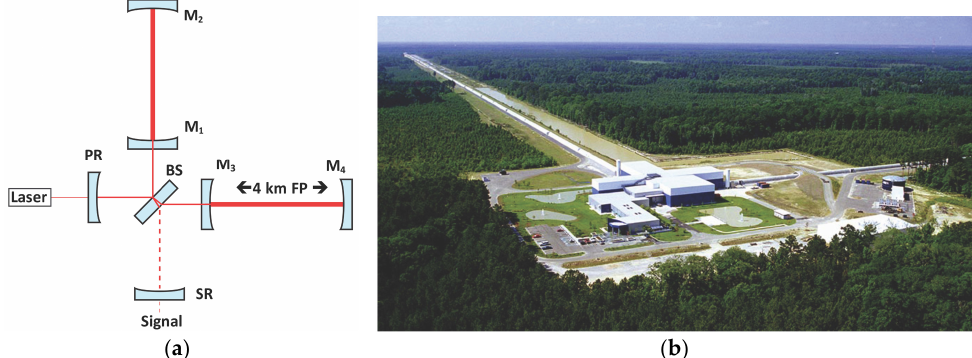
Figure 1. ( a ) Simplified schematic interferometric configuration used in Advanced LIGO; ( b ) LIGO Livingston gravitational wave detector.